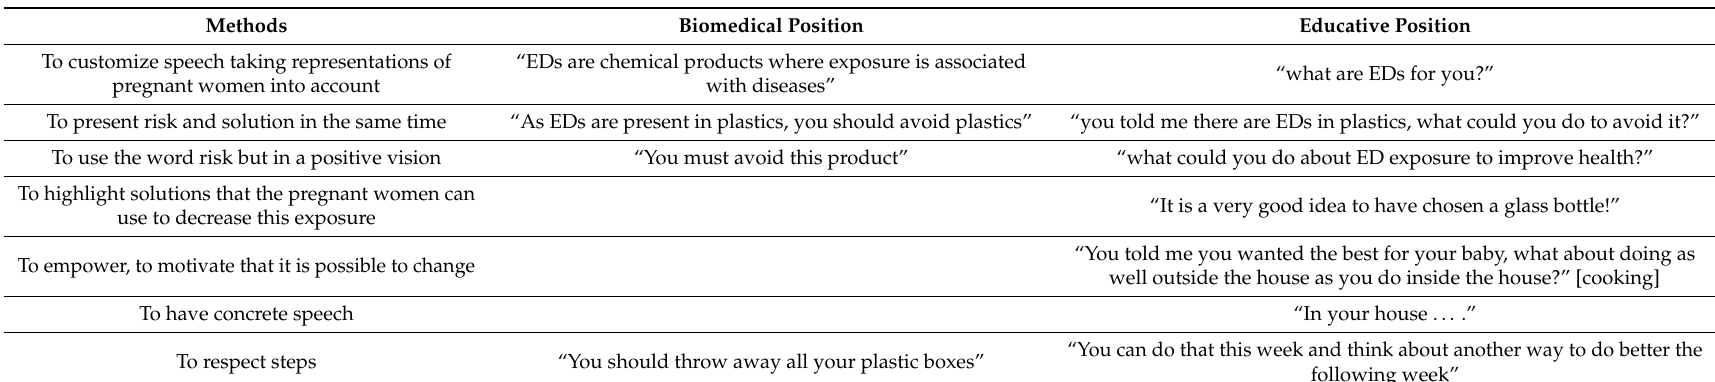
Table 2. Methods to educate pregnant women and questions to ask on an educational role in comparison with a biomedical